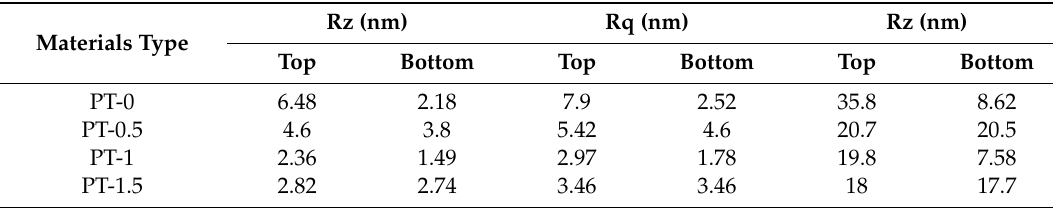
Table 4. The surface roughness parameters from AFM image.